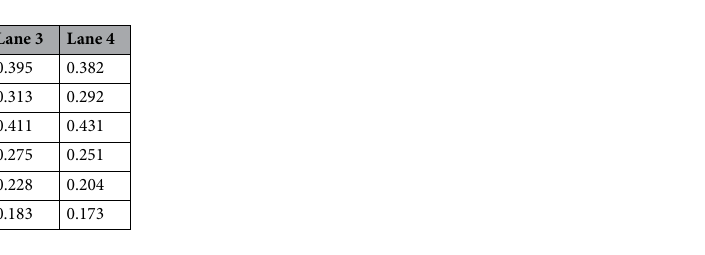
Table 3. Mean value of turbulence intensity at different lanes.